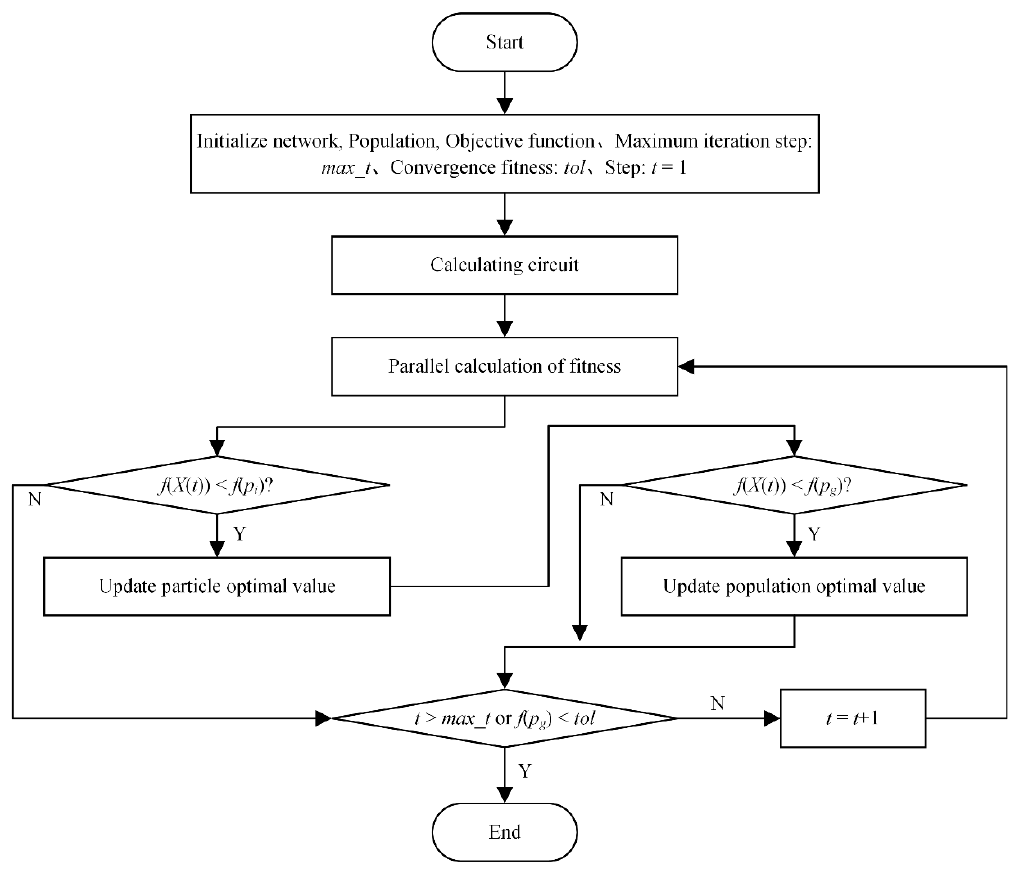
Figure 6. Application flow of ventilation intelligent decision-making.